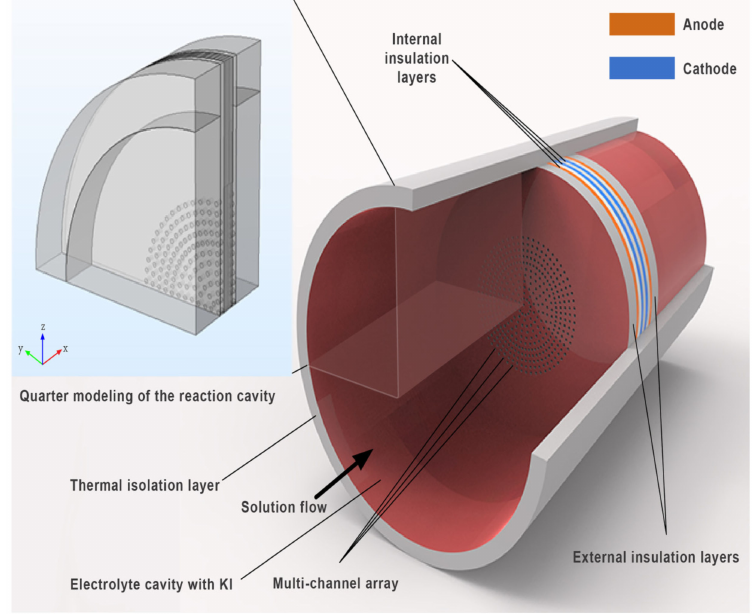
Figure 1. Integrated graph of the reaction